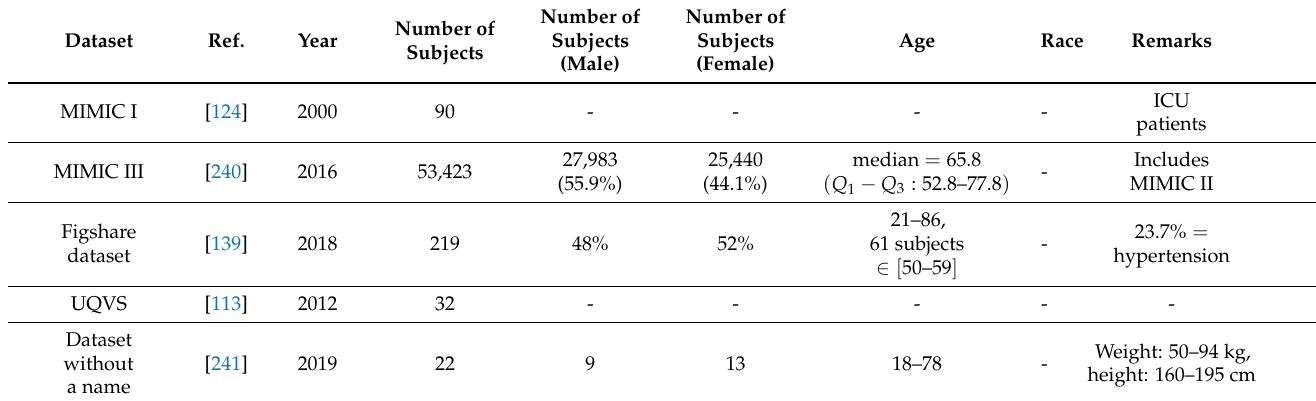
Table 5. Datasets used for verification of models in